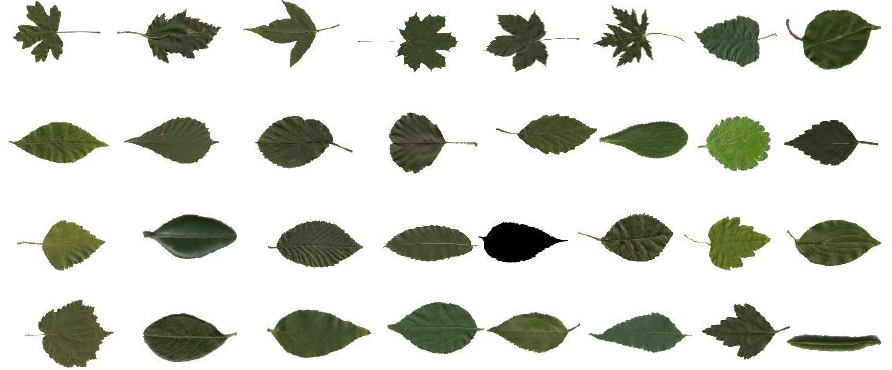
Figure 9. Standard leaf image of Swedish dataset.